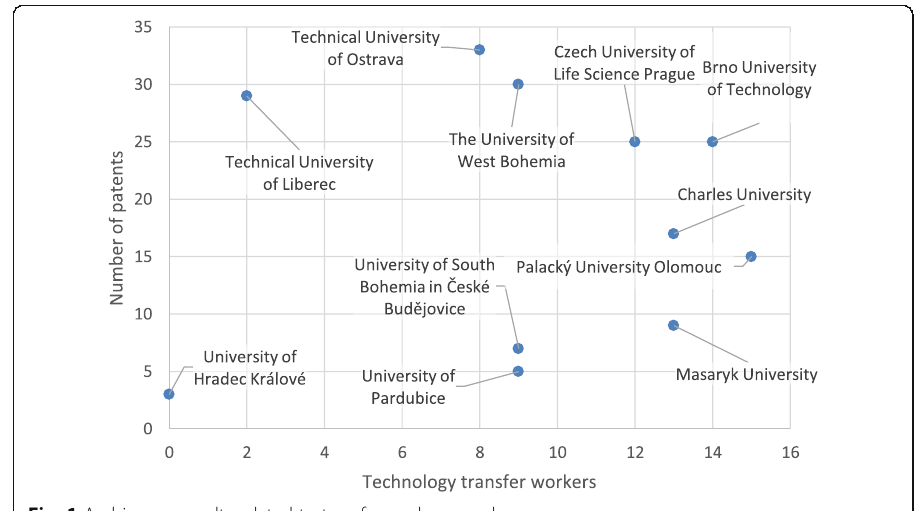
Fig. 1 Ambiguous results related to transfer workers